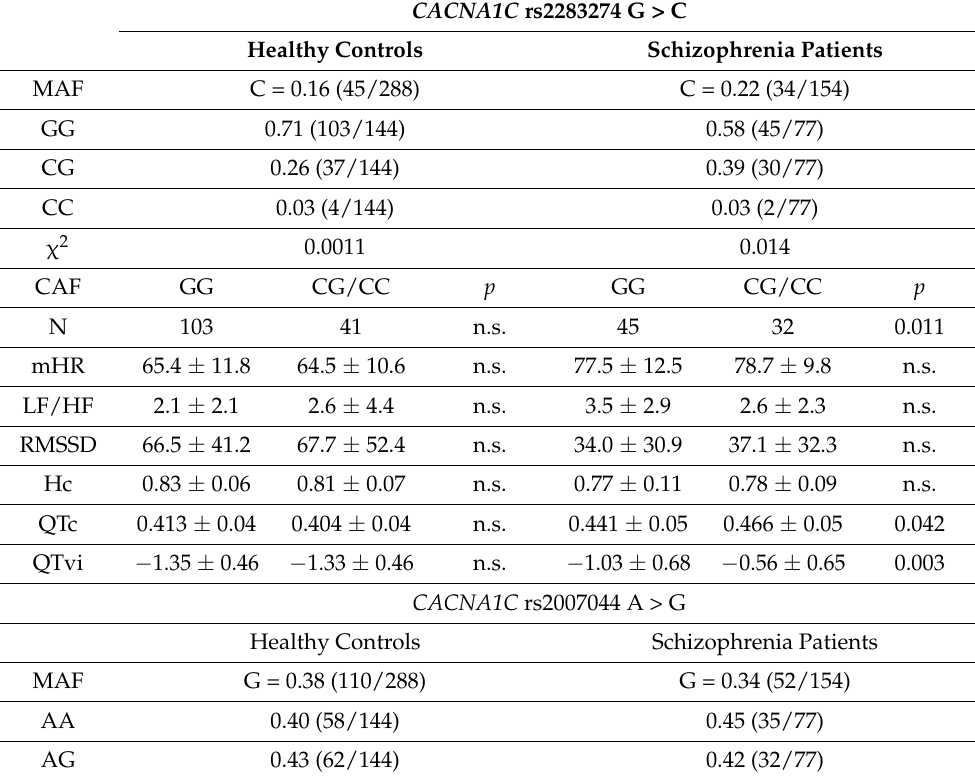
Table 3. Main Effect of CACNA1C Genotype Risk on Cardiac Autonomic